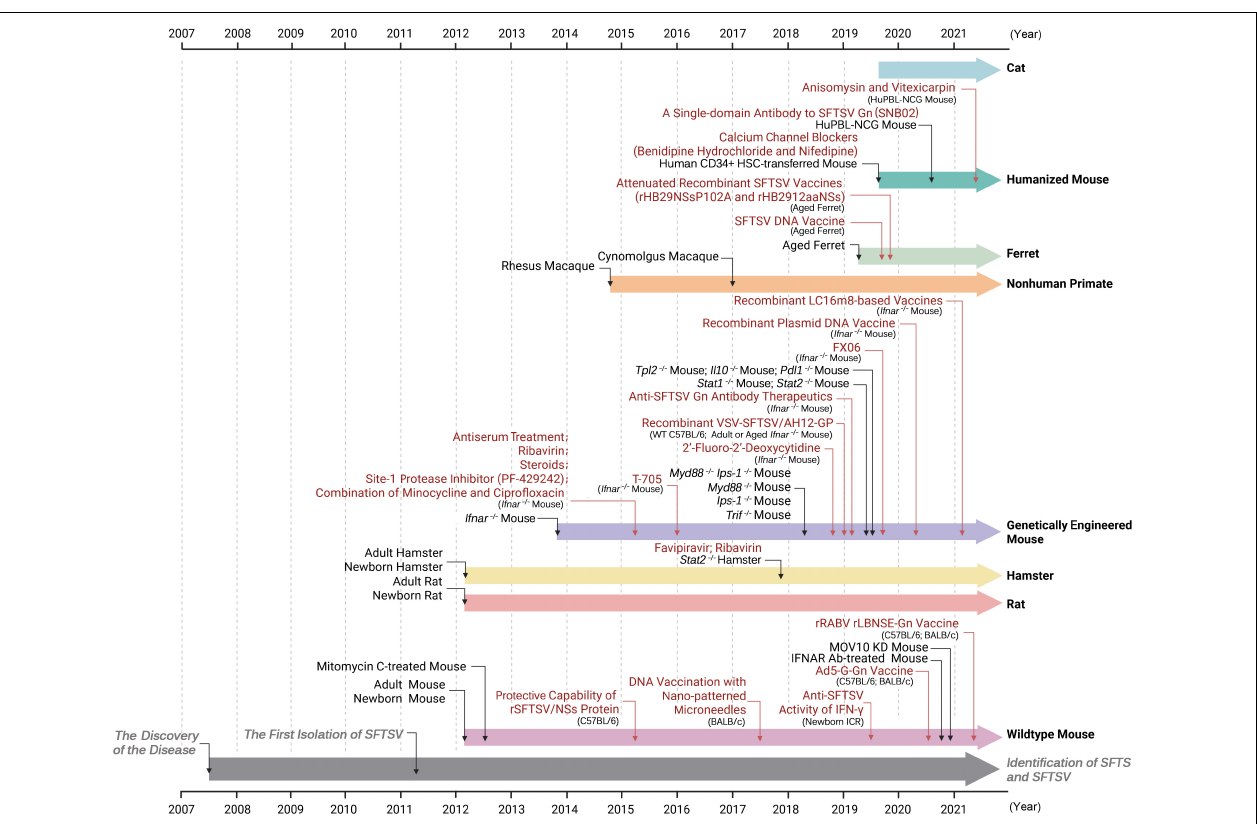
FIGURE 2 | Timelines of events: development of SFTSV animal models and their applications in the studies of anti-SFTSV drugs and vaccines. The reporting time of SFTSV researches from 2007 (the year when SFTS cases were first recorded) to 2021 is shown. Animal models tested or applied at the indicated time are shown in black font. Application studies of the animal models at the indicated time are depicted in red font. Researches firstly reporting SFTS and isolating SFTSV virions are marked in gray. See text for